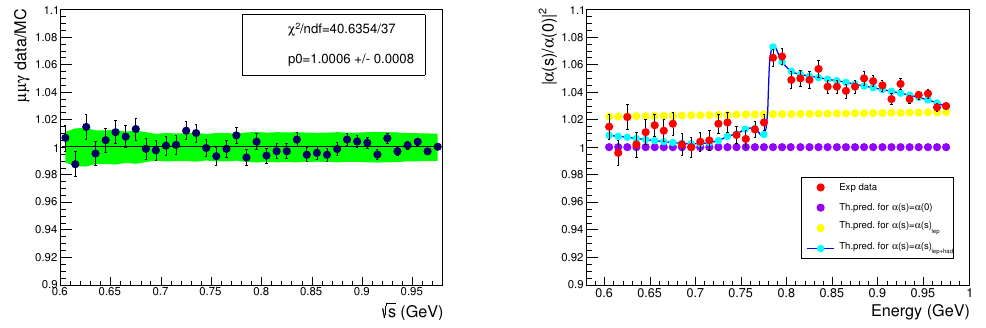
Figure 2. Left: Ratio between the measured di ff erential µ + µ − γ cross section and the MC prediction from PHOKHARA. The green band shows the systematic error. Right: The square of the modulus of the running α ( s ) in units of α (0) compared with the prediction (provided by the alphaQED package [10]) as a function of the dimuon invariant mass. The red points are the KLOE data with statistical errors; the violet points are the theoretical prediction for a fixed coupling ( α ( s ) = α (0)); the yellow points are the prediction with only virtual lepton pairs contributing to the shift ∆ α ( s ) = ∆ α ( s ) lep , and finally the points with the solid line are the full QED prediction with both lepton and quark pairs contributing to the shift ∆ α ( s ) = ∆ α ( s ) lep + had .